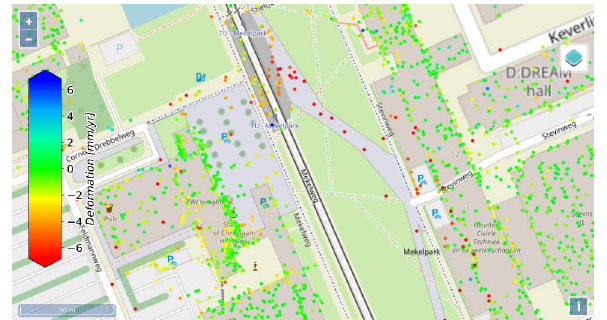
Figure 2. Traditional PS-InSAR deformation map, showing the TU Delft campus. Misalignment can be seen at the building facades. (Background: OpenStreetMap.)